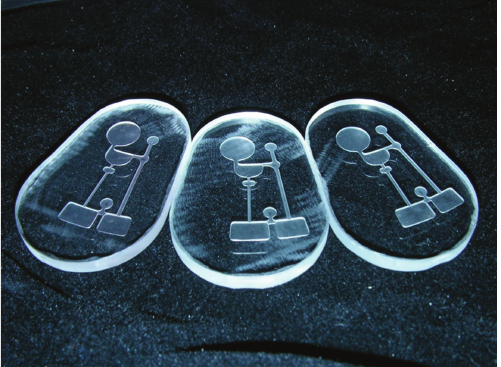
Figure 4: Centrifugal microfluidic chips with different widths of main